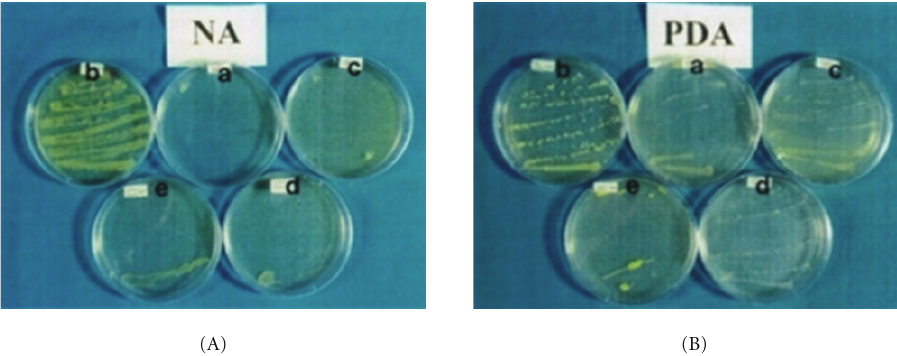
Figure 7: Growth of bacteria and fungi on (A) nutrient agar and (B) potato dextrose agar media plated on petri dish which contain copper coin (a), tap water (b), 8-HQC (c), P. betle leaf extract (d), and P. guajava leaf extract (e) on both media after day 3 of streaking vase solution of cut carnation flowers on day 9.